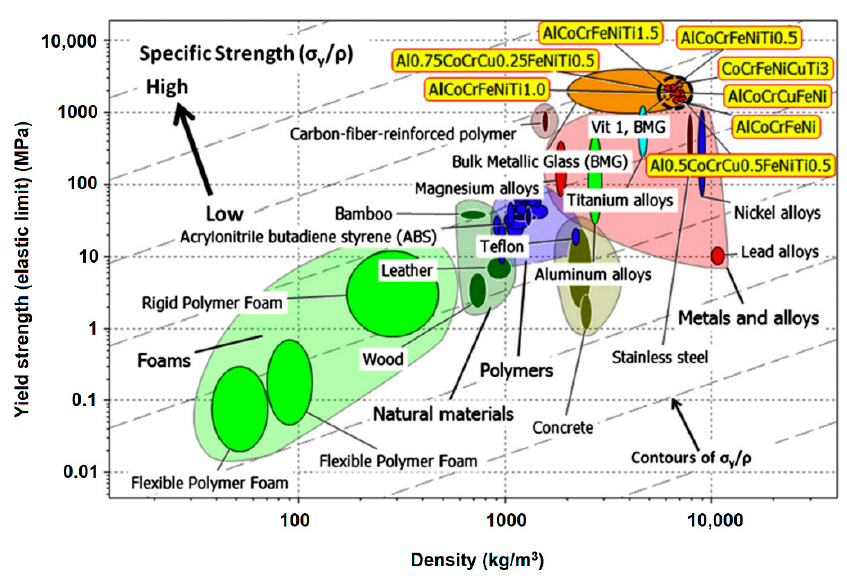
Figure 1. Yield strength versus density of HEAs (dark dotted circle) compared with other materials, particularly structural alloys. Reproduced with permission from Reference [17]. Copyright 2014 Elsevier.